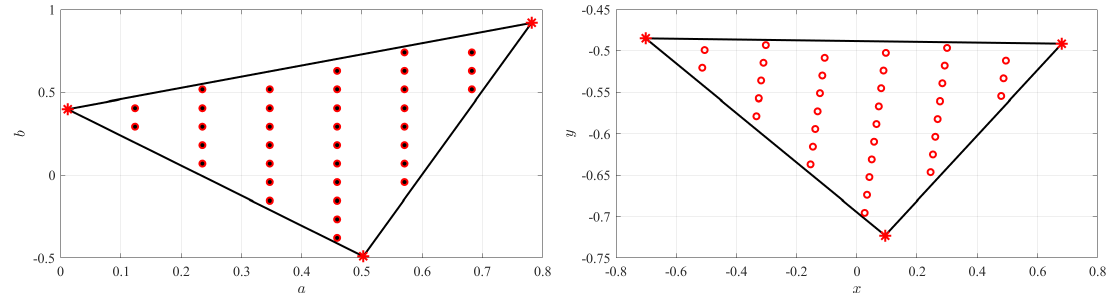
Figure 7. 3-points polynomial mapping